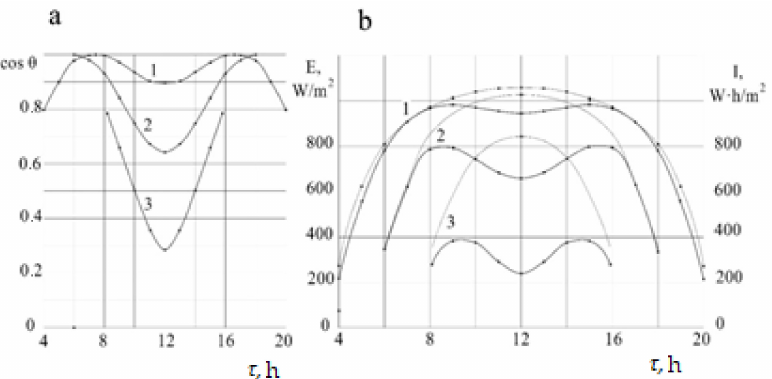
Figure 10. Orientation ( a ) and exposure ( b ) efficiency of the tracking surface of a horizontal- axis “north–south” tracker in the periods (own research): 1—summer solstice; 2—spring equinox; 3—winter solstice.